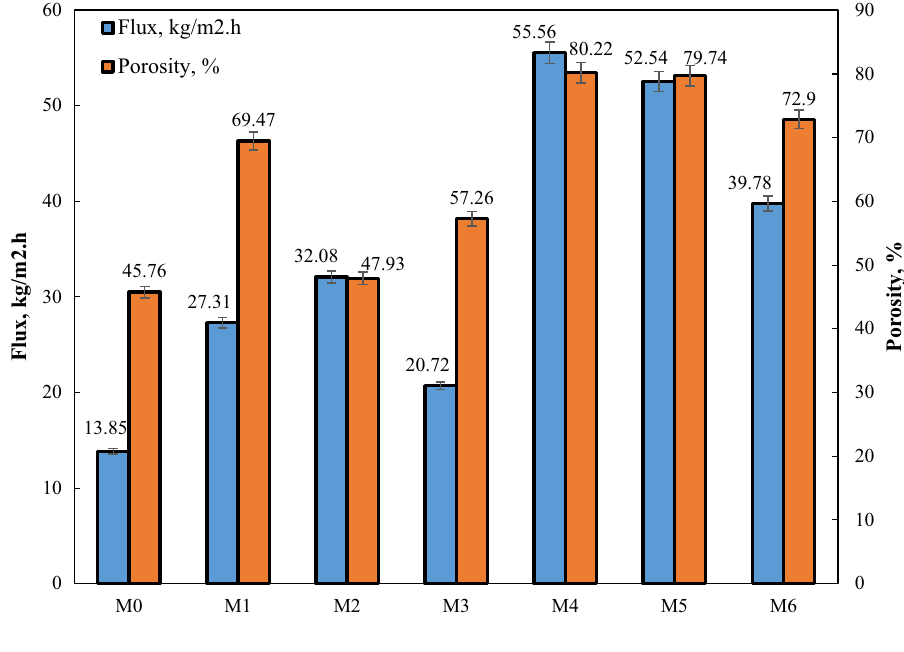
Fig. 2 PWF and porosity of the fabricated